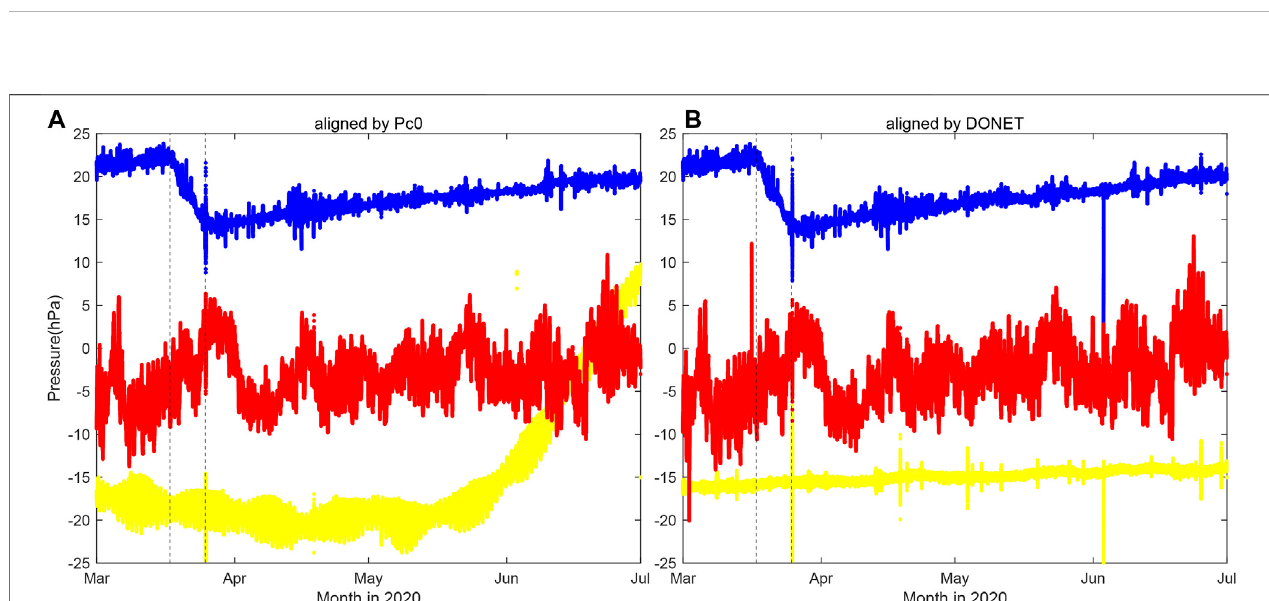
FIGURE 7 | Time history of pore pressure in case of reference sea fl oor pressure treated as (A) Pc0 and (B) P DONET _raw with the fi xed parameters in Table 1 . The others are the same as Figure 2 .